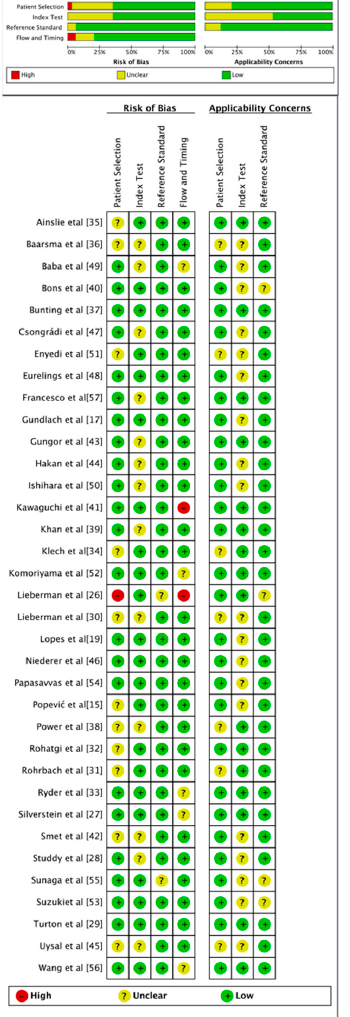
Figure 1. Quality assessment of studies included in the meta-analysis.